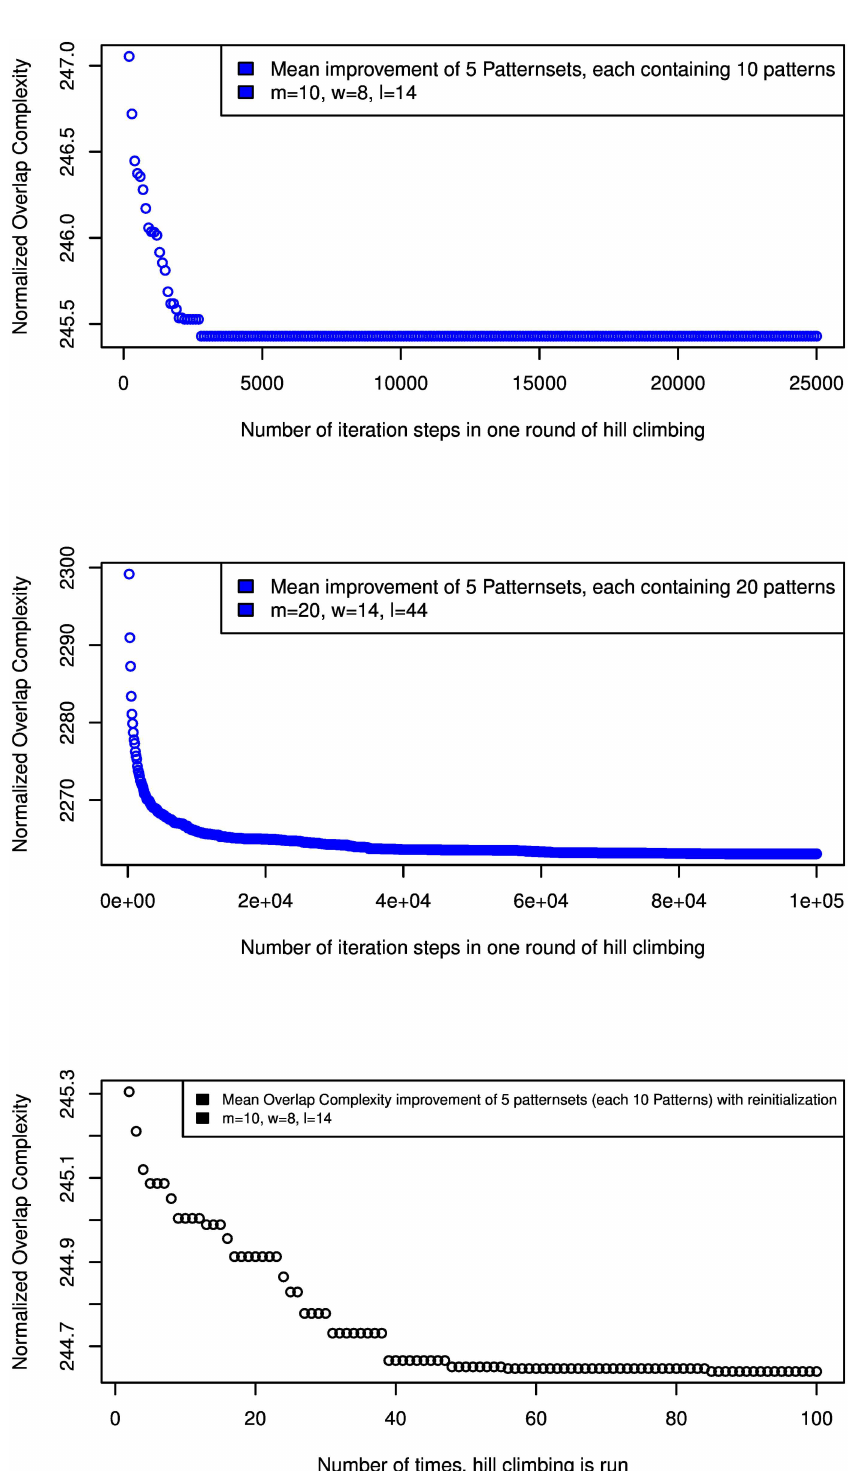
Fig 4. overlap complexity of pattern sets in the hill-climbing algorithm. Normalized overlap complexity (OC) of pattern sets dependingon the number of iteration steps in our algorithm. The first two plots show how the OC is reducedin a single round of the hill-climbing algorithm for different parameters. For a set of m = 10 patterns of length ℓ = 14 and weight w = 8, the algorithm convergesafter around 3,000 iteration steps of hill- climbing (upper plot); for a set of m = 20 patterns of length ℓ = 44 and weight w = 14, it convergesafter